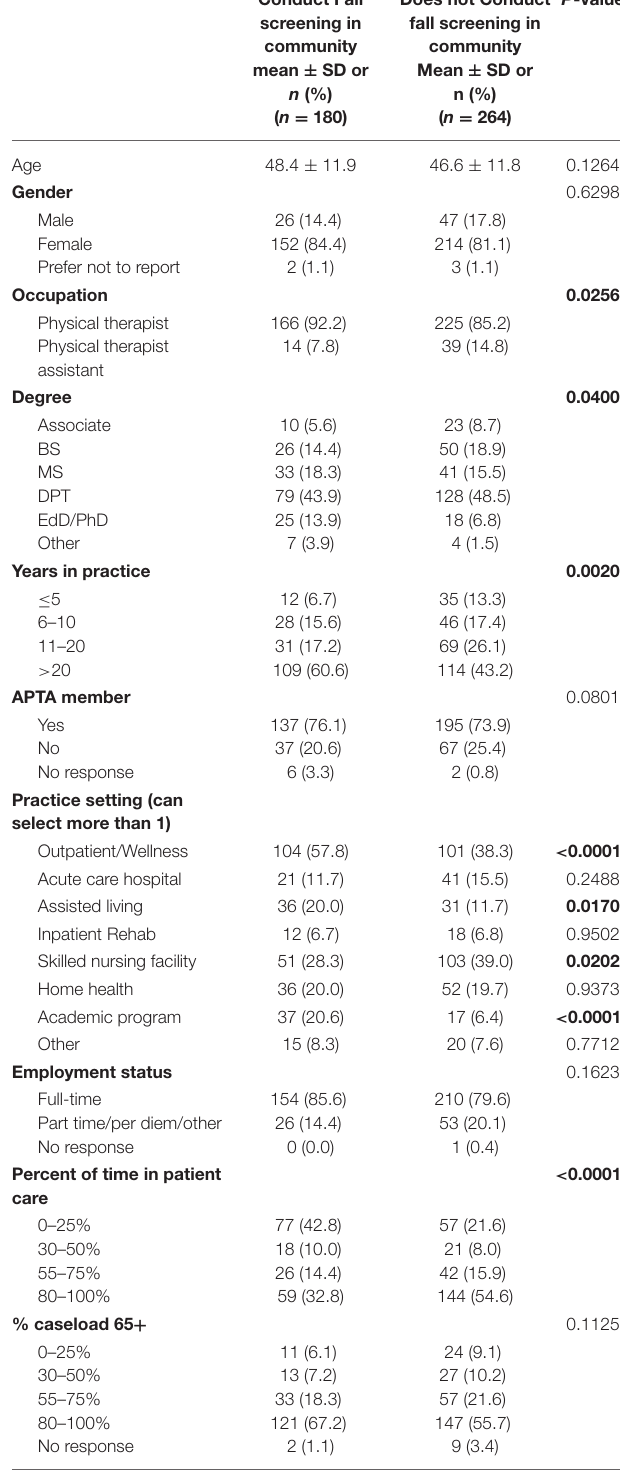
TABLE 2 | Frequency of Community Falls Risk Screening and Knowledge and Use of the STEADI Toolkit ( n = 444). Survey item